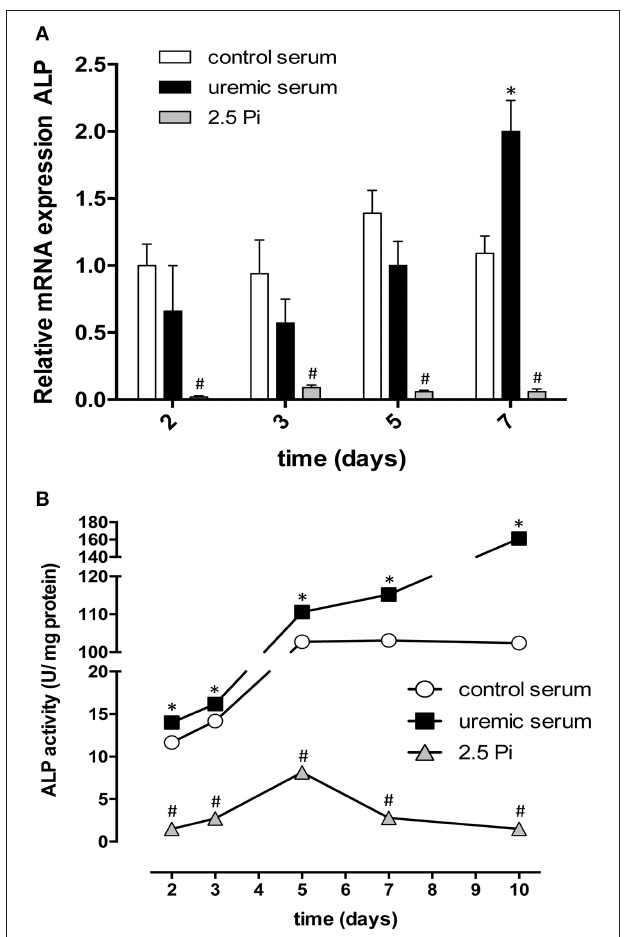
FIGURE 3 | Expression and activity of alkaline phosphatase are increased by uremic serum but potently reduced by high phosphate. (A) Alkaline phosphatase (ALP) mRNA expression in HASMC incubated in DMEM for the indicated amount of time with increased Pi and Ca 2 + (2.5 Pi), or in DMEM supplemented with 20% control or uremic serum. The expression of ALP gene was normalized to GAPDH. Results are presented as the mean ± SE ( N = 3); *significant vs. control serum; # significant vs. uremic serum. (B) Intracellular ALP activity measured using a colorimetric assay. Each measurement was normalized for total protein. Data are shown as mean ± SE ( N = 3). Values were compared using a one-way ANOVA followed by Tukey’s multiple comparisons test. *Significant vs. control serum; # significant vs. uremic serum.